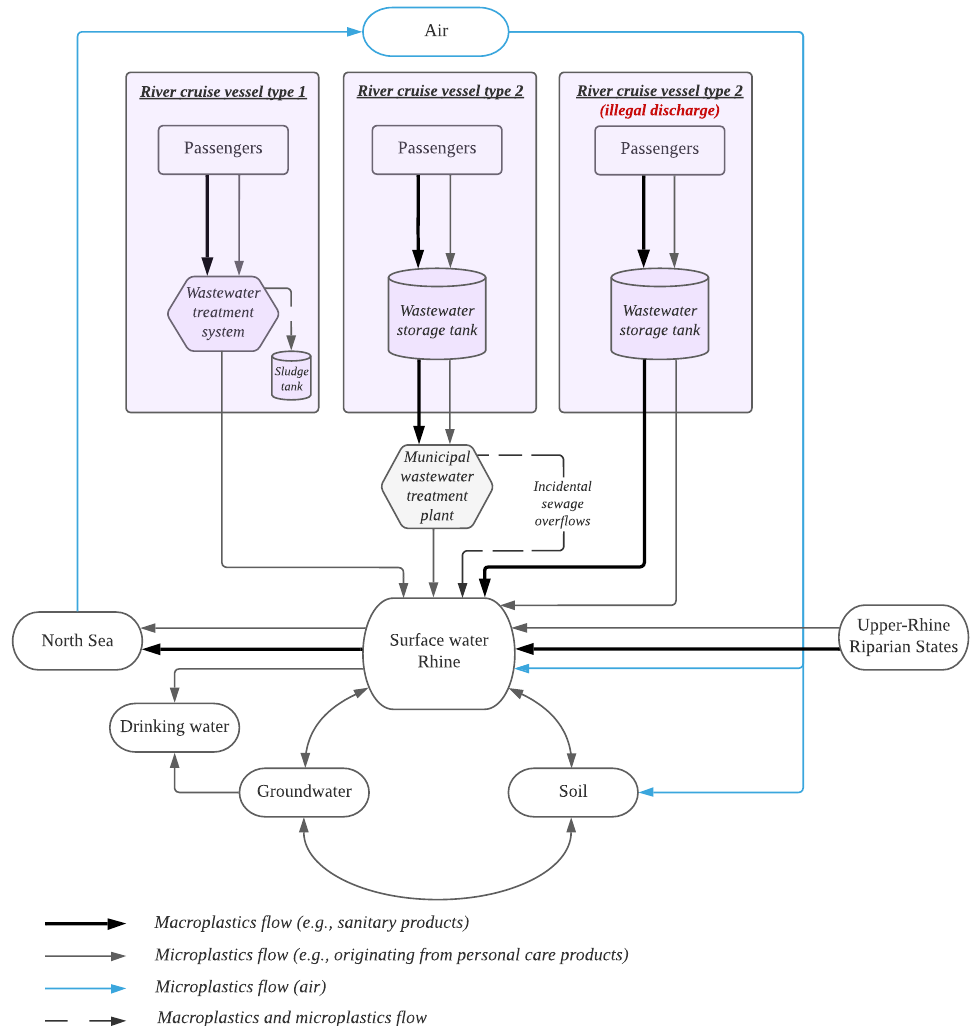
Figure 2. Distribution of macroplastics and microplastics from wastewater generated by passengers in the bathrooms onboard river cruise vessels to aquatic environments, adapted from Derksen